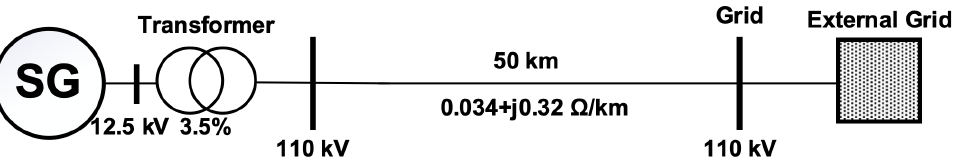
Figure 20. Single-machine test system for dynamic performance analysis with different short-circuit